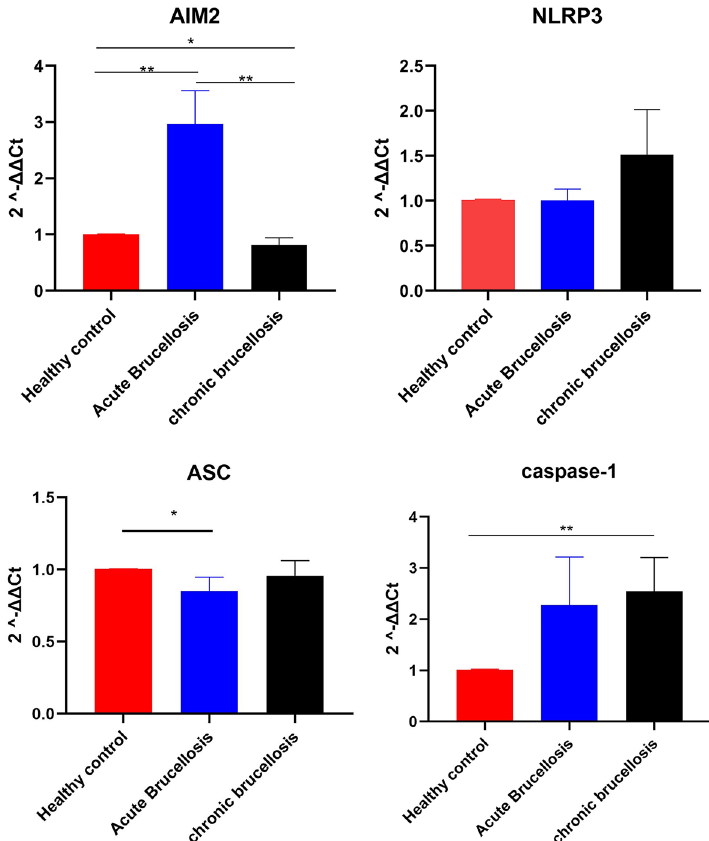
Figure 2. Description and differences of NLRP3, AIM2, ASC, Caspase-1 gene expression levels in each experimental group. The CT value was automatically generated by the fluorescence quantitative PCR instrument analysis software. The gene relative transcription levels were calculated by the 2−ΔΔct method. Analysis of the relative transcript levels of AIM2, NLRP3, ASC and caspase-1 genes in healthy control group, acute brucellosis group and chronic brucellosis group. Beta-actin has been used as a housekeeping gene. *symbolizes statistically significant change in the acute or chronic brucellosis group in comparison with healthy control. 2−ΔΔct were presented with ± SE. ** P < 0.01,* P < 0.05.